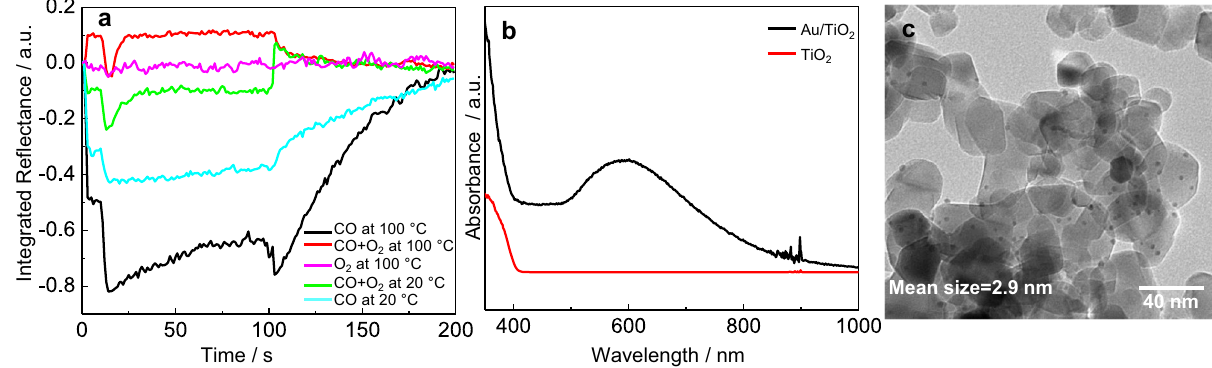
Fig. 4 | In situ UV-vis signal as a function of time, diffuse re fl ectance UV-vis spectra of TiO 2 and Au/TiO 2 , and TEM image of Au/TiO 2 . a UV-vis signal (inte- grated re fl ectance between 750 and 950nm) as a function of time during CO oxi- dation, CO adsorption, and O 2 adsorption at 20 and 100°C. Experimental